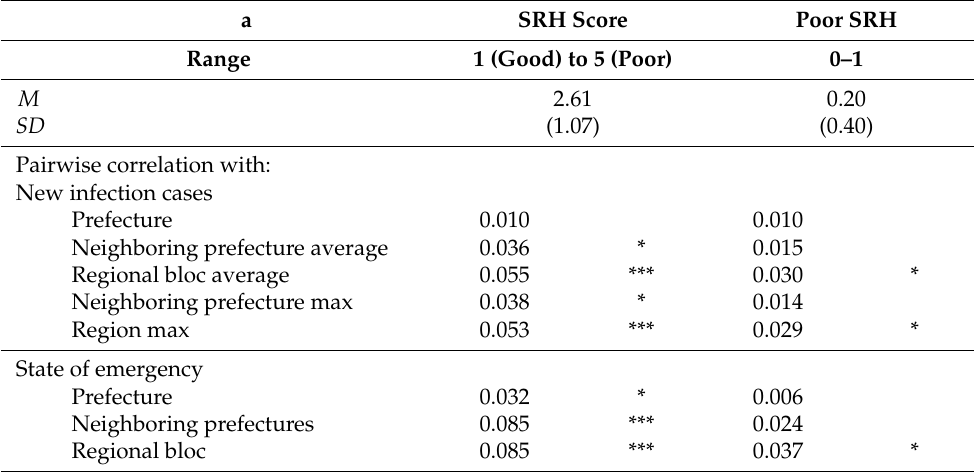
Table 2. Pairwise correlation analysis between self-rated health and COVID-19 infection ( N = 4520 observation of 2260 individuals).